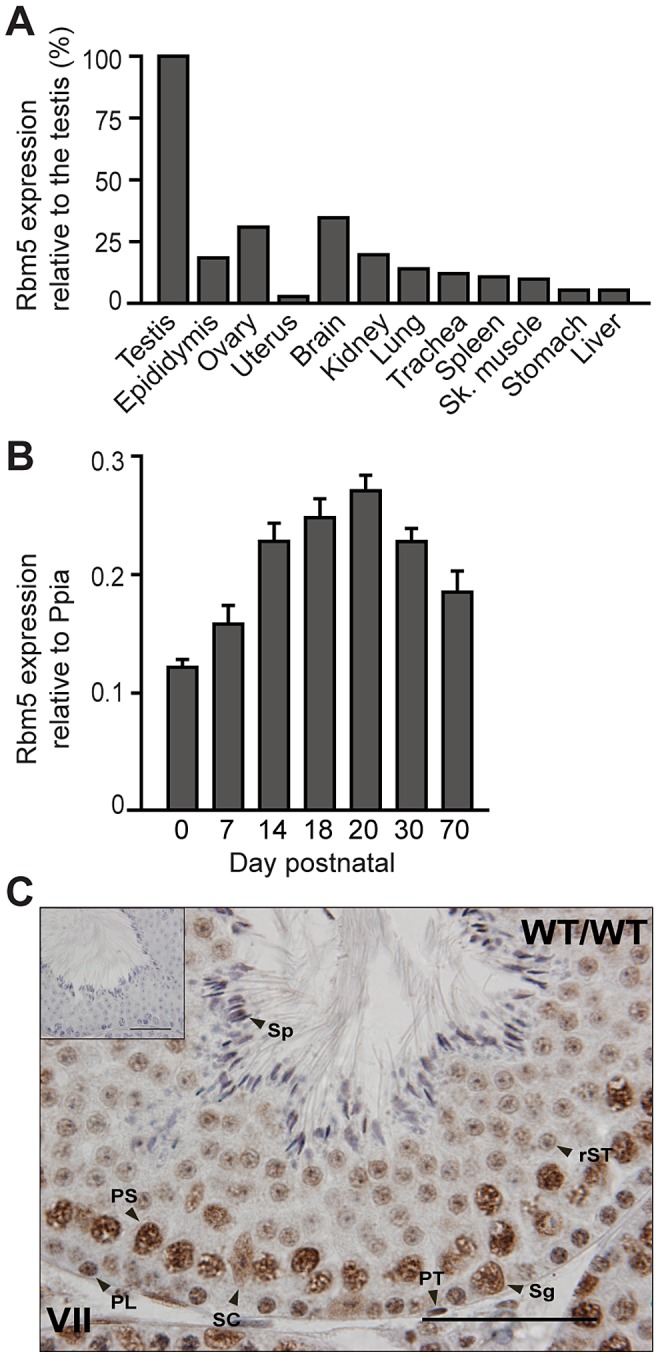

Rbm5 mRNA is highly expressed in the testis where the protein localises in somatic and germ cells.(A) Rbm5 mRNA expression in various tissues and (B) during the establishment of the first wave of spermatogenesis. Sk: skeletal. Error bars = S.D. (standard deviation, n = 3 wild-type C57BL/6JxCBA mice, per age group) (C) RBM5 protein localisation in an adult Rbm5WT/WT testis. (C, inset) RBM5 antibody pre-absorption control. Sg: Type A spermatogonia, PL: preleptotene spermatocyte, PS: pachytene spermatocyte, rST: round spermatid, Sp: spermatozoa, SC: Sertoli cell, PT: peritubular cell. Scale bars = 50 µm.